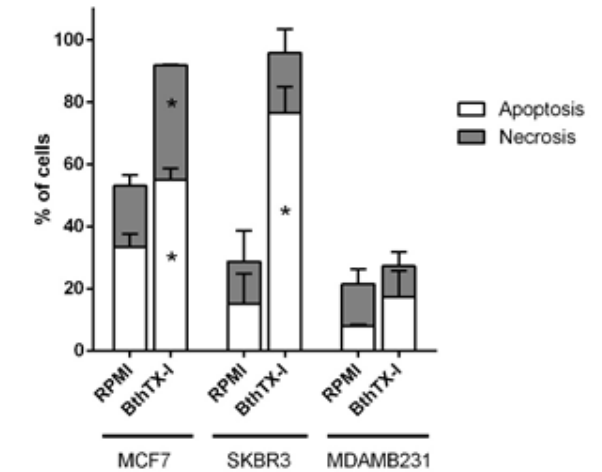
Figure 2. Cell death profile of breast cancer cell lines treated with BthTX-I at 102 µg/mL for 24h. Cell death was analyzed by the annexin V and propidium iodide staining flow cytometric method. RPMI: cells incubated in estrogen-free RPMI 1640 medium supplemented with CS-FBS (negative control). Values represent mean ± SD of at least three independent experiments. * p < 0.05 vs. negative control (Student’s t